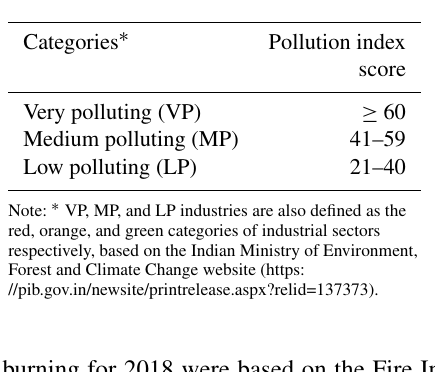
Table 1. The criteria on the “range of pollution index” for the pur- pose of categorization of industrial